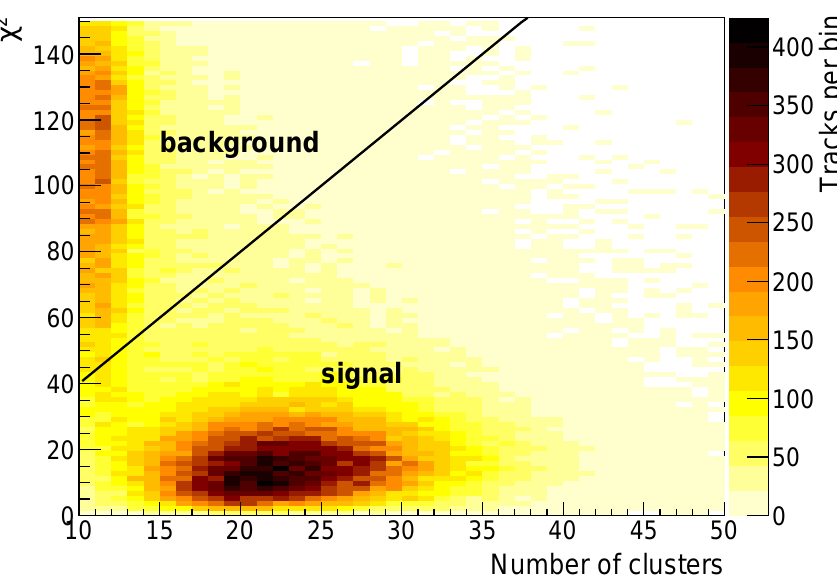
Figure 11. χ 2 test to separate the muon signal from the background tracks ( β rays or randomly formed